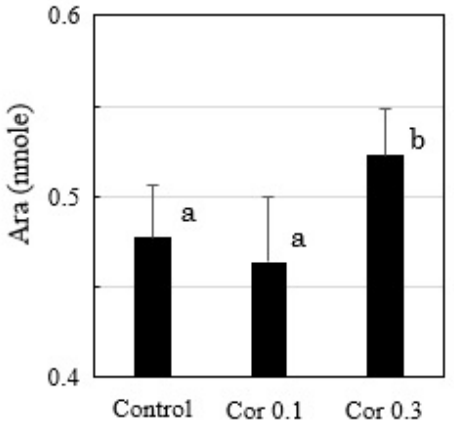
Figure 6. HPLC analysis of free Ara in the cultured uterine epithelial cells with or without hydrocortisone (0.1, 0.3 μM) treatments (n = 3). a,b Different lowercase letters indicate statistically significant differ - ences among treatments (p<0.05). HPLC, high performance liquid chromatography.